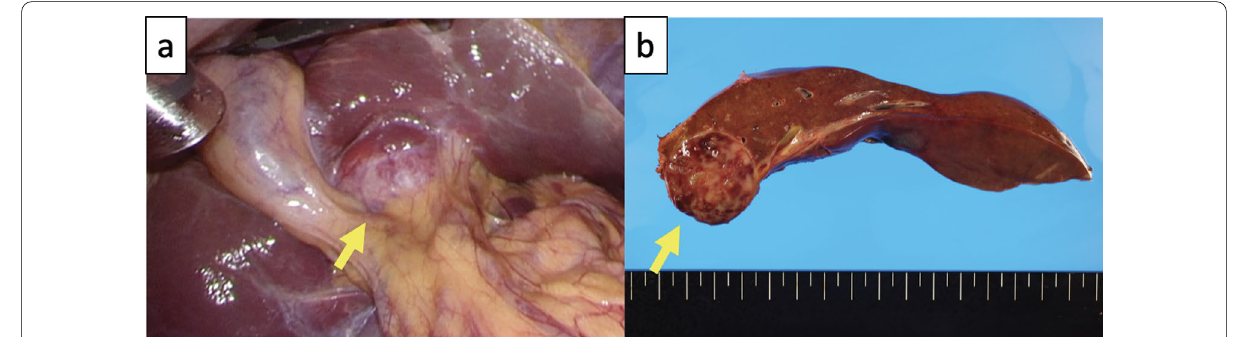
Fig. 2 Intraoperative and macroscopic findings of EBV-associated FDCS. a Case underwent laparoscopic extended left hepatectomy (yellow arrow). b Mass measuring 3.5 cm in size, with a well-circumscribed margin, milky-white in color, and with necrotic components is noted. EBV: Epstein–Barr virus; FDCS: follicular dendritic cell